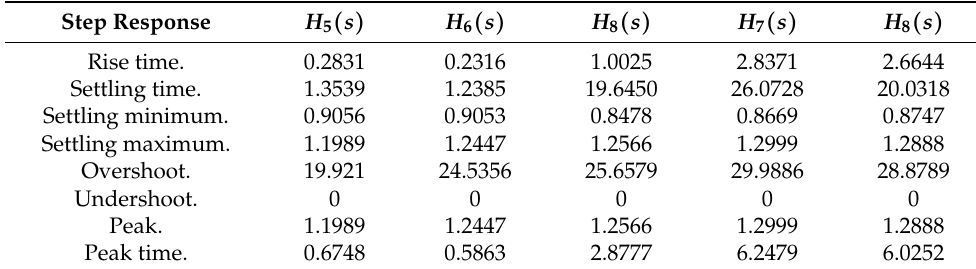
Table 5. Step responses of H 6 ( s ) , H 7 ( s ) , H 8 ( s ) , H 9 ( s ) and H 10 ( s ) .